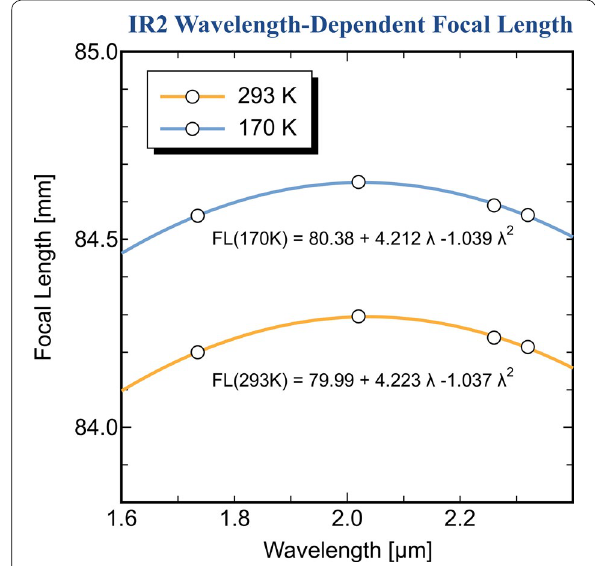
Fig. 10 Theoretical focal lengths of IR2 triplet optics (open circles) for the four Venus filters (1.735, 2.02, 2.26, and 2.32 μm) at two different temperatures (293 and 170 K). Curves (quadratic functions) were obtained by a least‑squares fit to the points, and the coefficients are shown in the figure